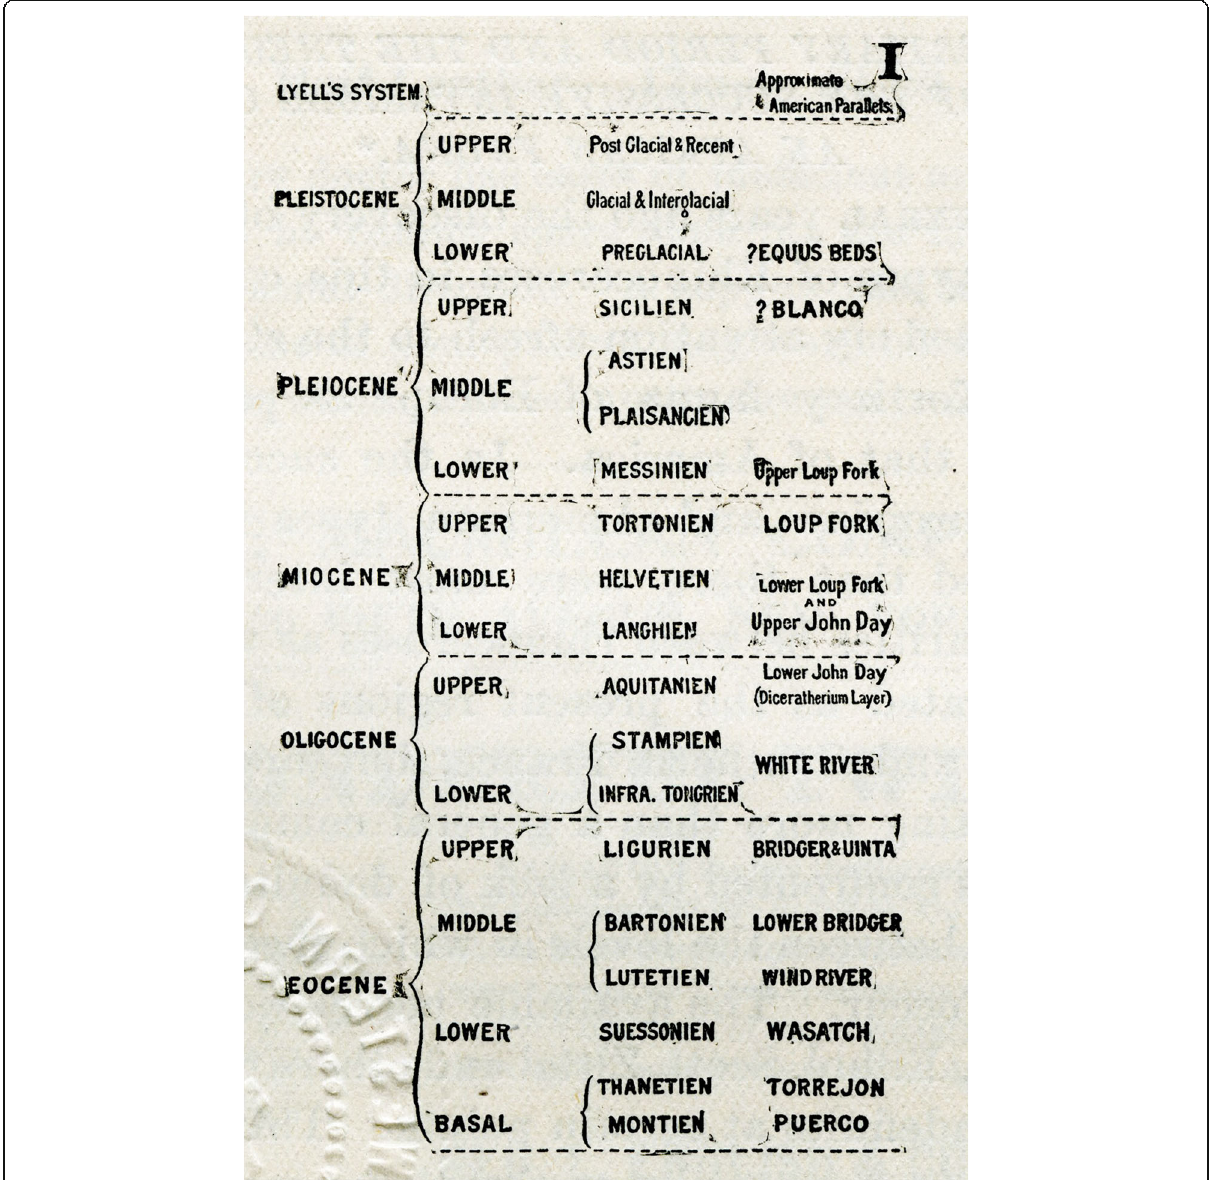
Fig. 3 Reproduction of Chart 1 of Osborn (1900), an early example of the tripartite subdivision of the Pleistocene along with other Cenozoic series and their subdivision. The word Pleiocene, from the Greek plei ō n (Latinized as plio- ), is a rare variant spelling of